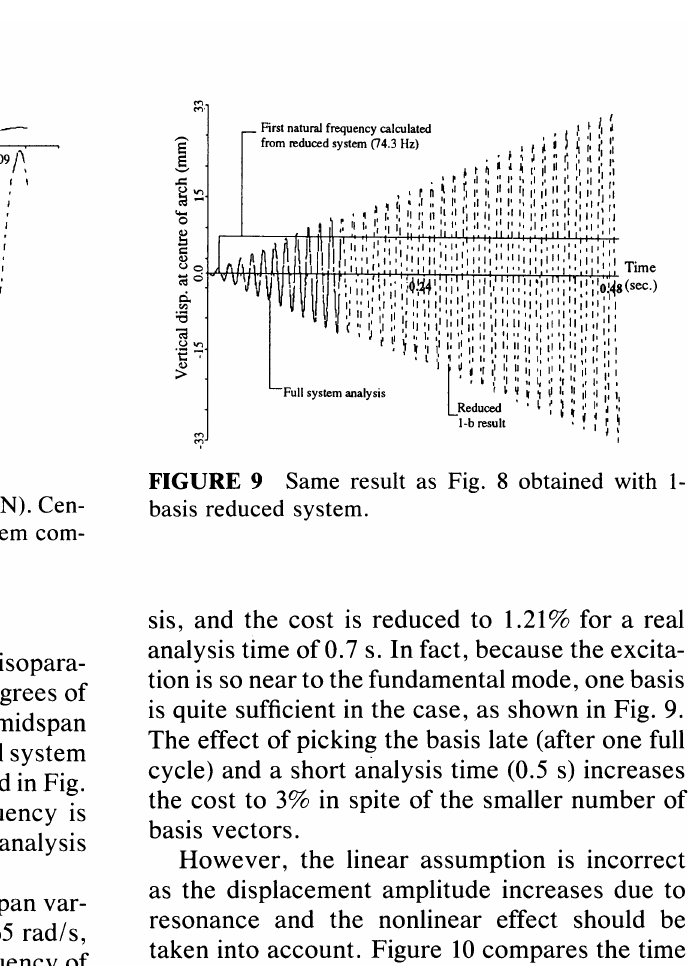
FIGURE 7 Shallow arch under step load (50 N). Cen tral deflection response, 8-basis reduced system com pared to full system analysis.